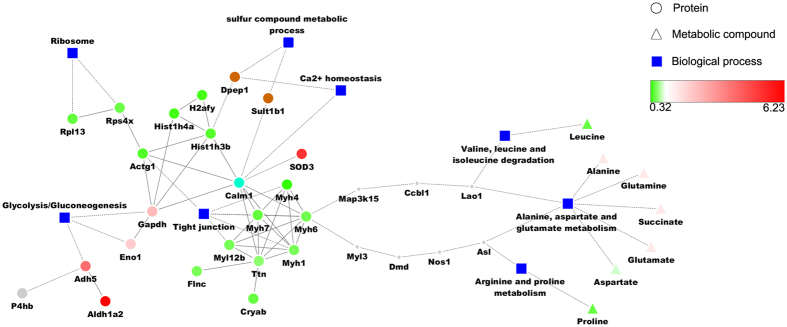
Key regulation model constructed using proteomic and metabolomic data.Circle nodes indicate proteins and triangle nodes indicate metabolic compounds. Filled color represents expression fold change using gradient color from blue to red. Blue colored rectangle indicates KEGG pathways. A solid line between two proteins indicates a known interaction annotated in the STRING database; a dashed line between proteins indicates indirect interaction. Gray-colored dots are extended proteins from the database that built up a potential path from the proteomic to the metabolomic layer.